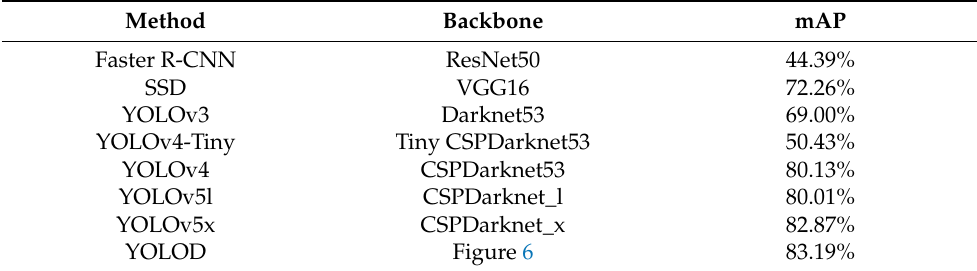
Figure 8. Results after visualizing the model: ( a – e ) show the detection accuracy and corresponding masks for different classes. Table 5. Experimental results of comparative